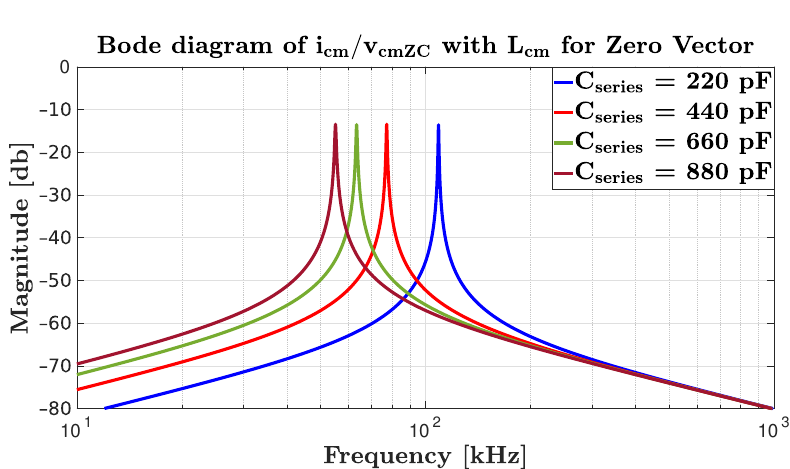
Figure 19. Equivalent common mode circuit with Common mode Filter.